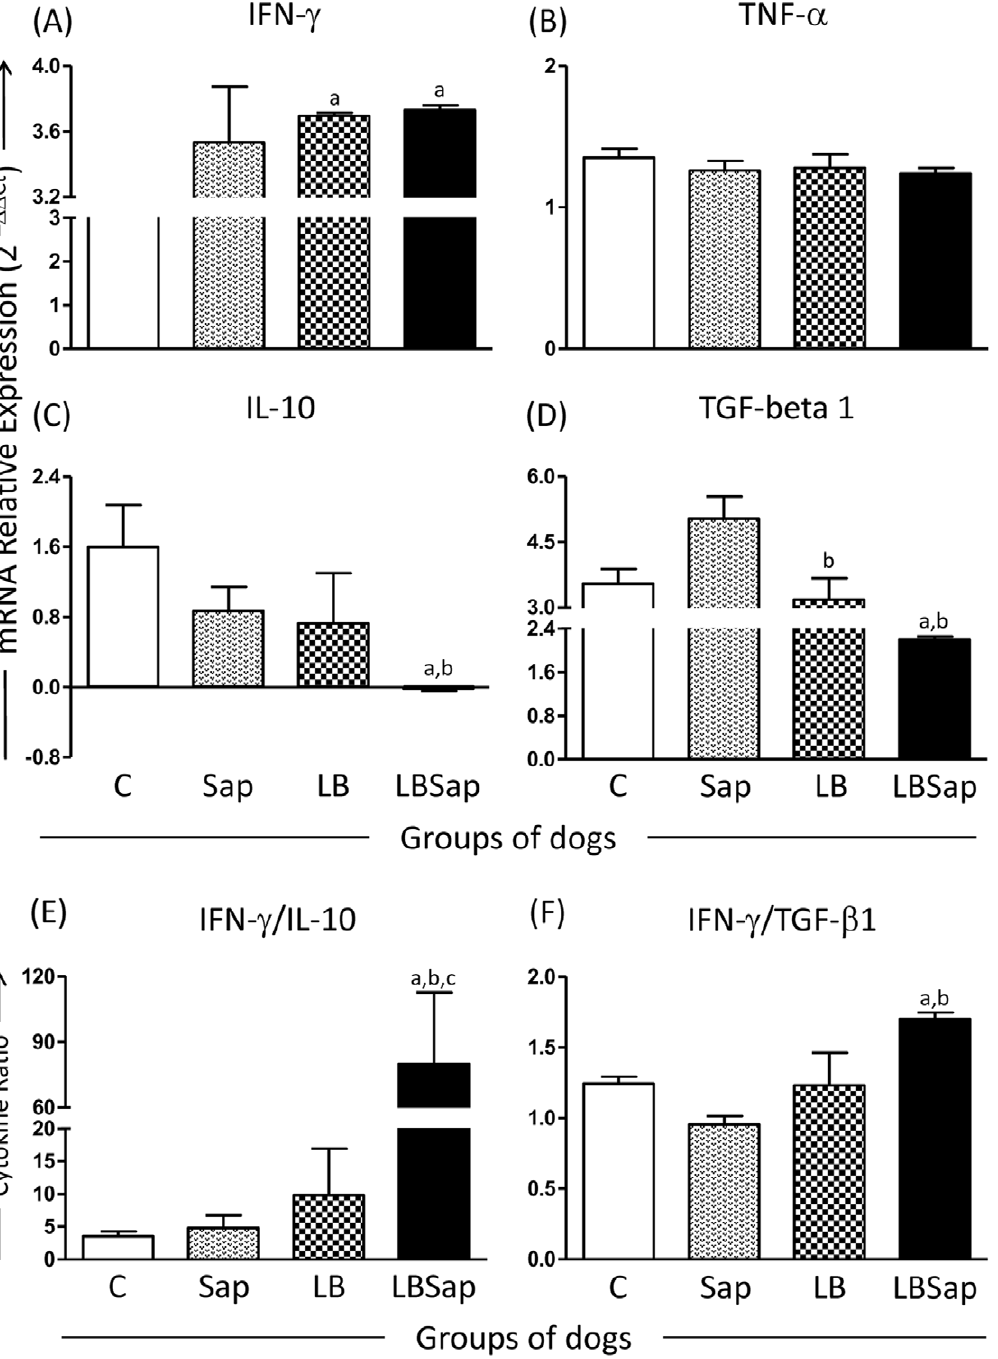
Figure 4. Evaluation of cytokine mRNA levels in spleen samples at 885 dac (days after challenge with L.infantum plus SGE) for vaccinated groups: C (control; white); Sap (saponin; white with weak hatched); LB (killed L.braziliensis vaccine; white with strong hatched); LBSap (killed L.braziliensis vaccine plus saponin; black). The Log number of messenger RNA molecules for (A) IFN- c , (B) TNF- a (C) IL-10 and (D) TGF- b 1 and the cytokines ratio (E) IFN- c /IL-10 and (F) IFN- c /TGF- b 1 are shown. Results were plotted representing median values for each group. Significant differences ( p , 0.05) between the LBSap and the control C, Sap and LB groups are represented by the letters a, b and c, respectively.